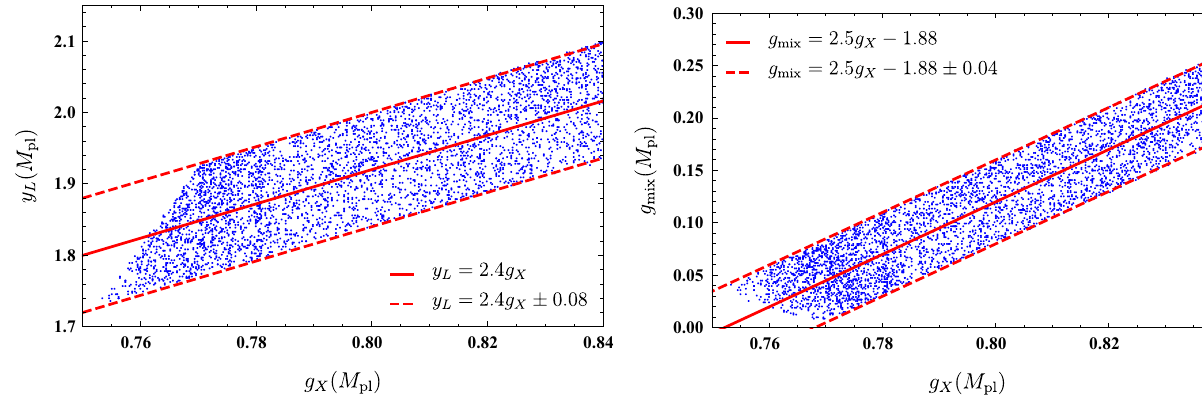
Fig. 3 Allowed region plots for coupling constants, y L ( M pl ) (left) and g mix ( M pl ) (right), as functions of g X